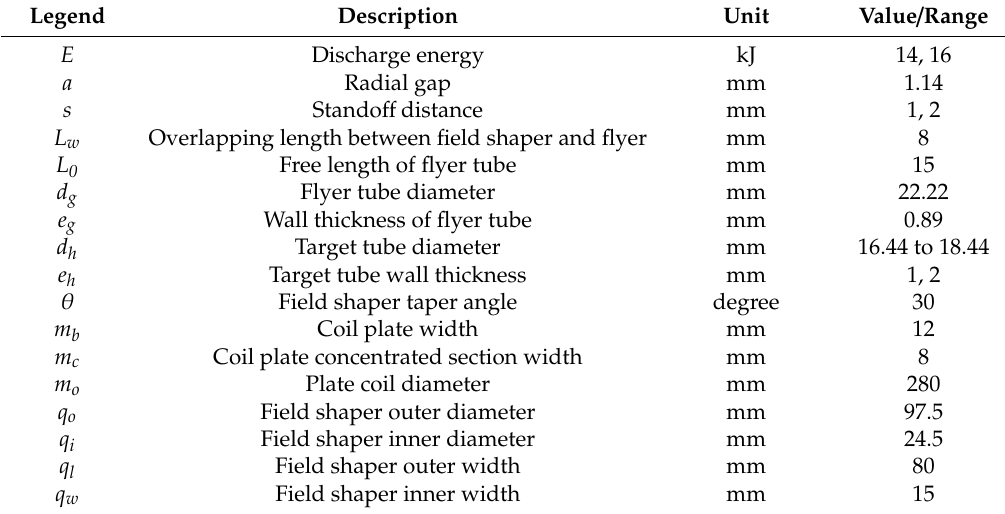
Table A1. Process conditions and dimensions of coil and tubes